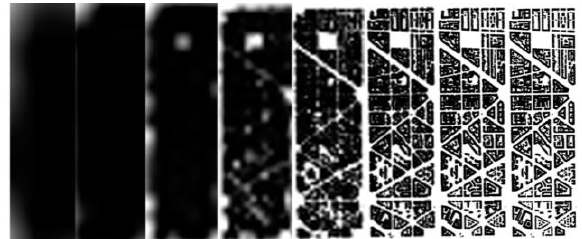
Figure 1 . Resolution-clusterization analogy. From building to urban patch bottom-up